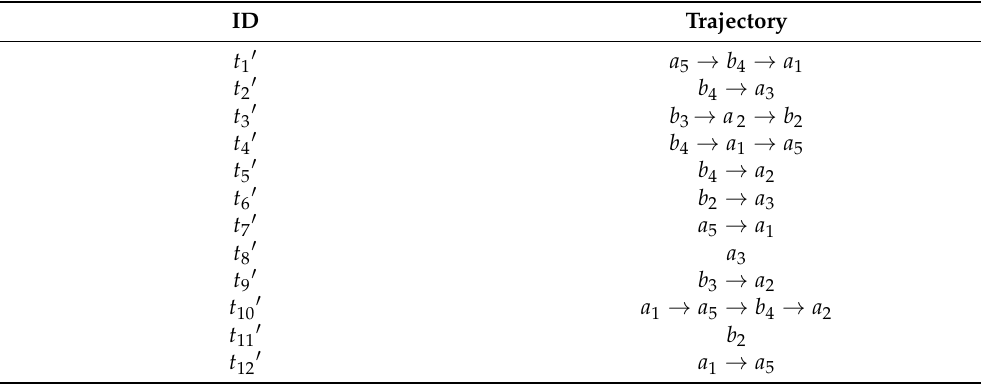
Table 4. A corresponding safe dataset T ∗ of T